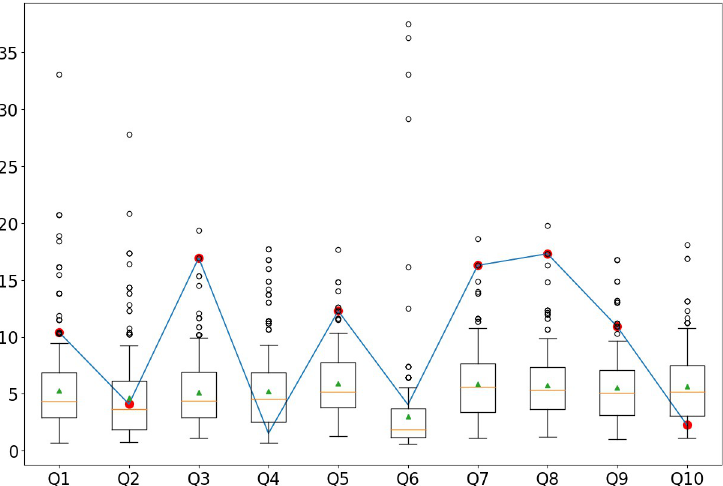
Fig 6. TF-IDF response values for participant 48 (dishonest responses) compared to the distributions of TF-IDF values of honest respondents in the JIS dataset. The red dots indicate the items in which the participant faked. In this specific case, Q4 and Q6 received the same response in the honest and dishonest conditions (i.e., the subject did not fake). Among the eight dishonest responses, the TF-IDF algorithm accurately spotted six of eight dishonest responses. The total accuracy is